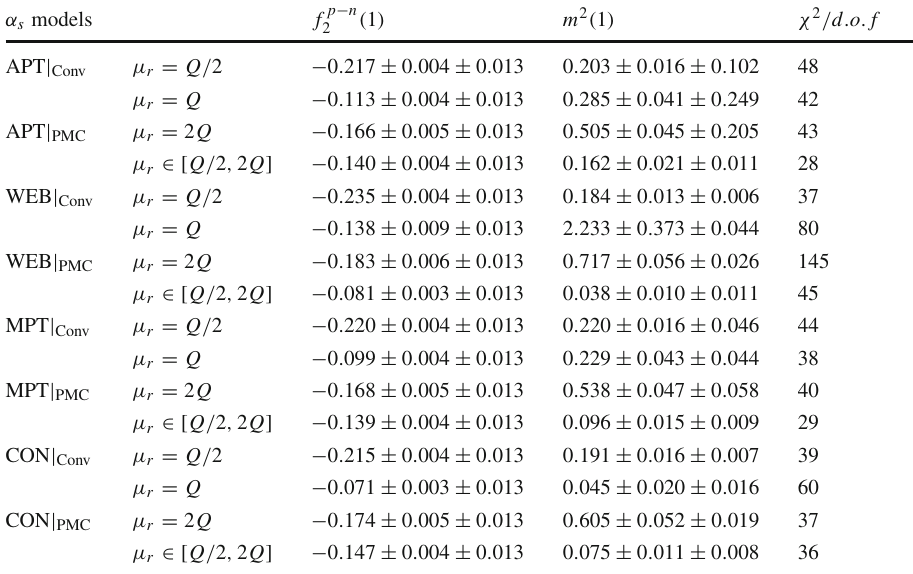
Table 2 The fitted parameters − n ( Q 2 = 1 GeV 2 ) and f p 2 m 2 ( Q 2 = 1 GeV 2 ) and their corresponding quality of fit χ 2 / d . o . f under four α s models before and after applying the PMC, where the first and the second errors are caused by the statistical and systematic errors of the experiments